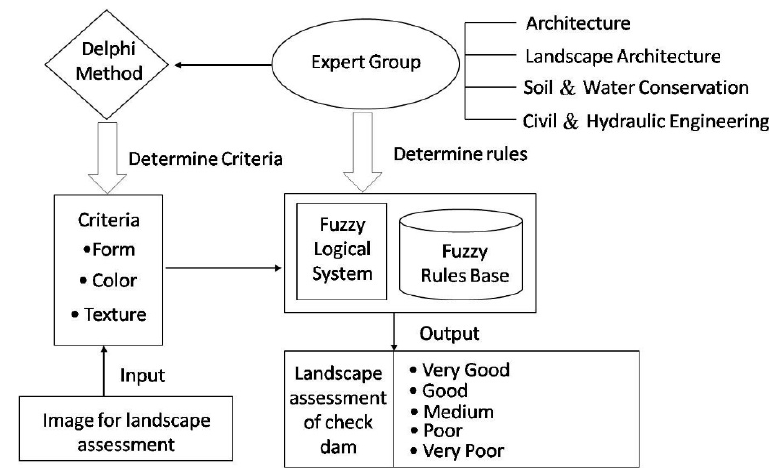
Figure 2. Flow chart of fuzzy logical system.